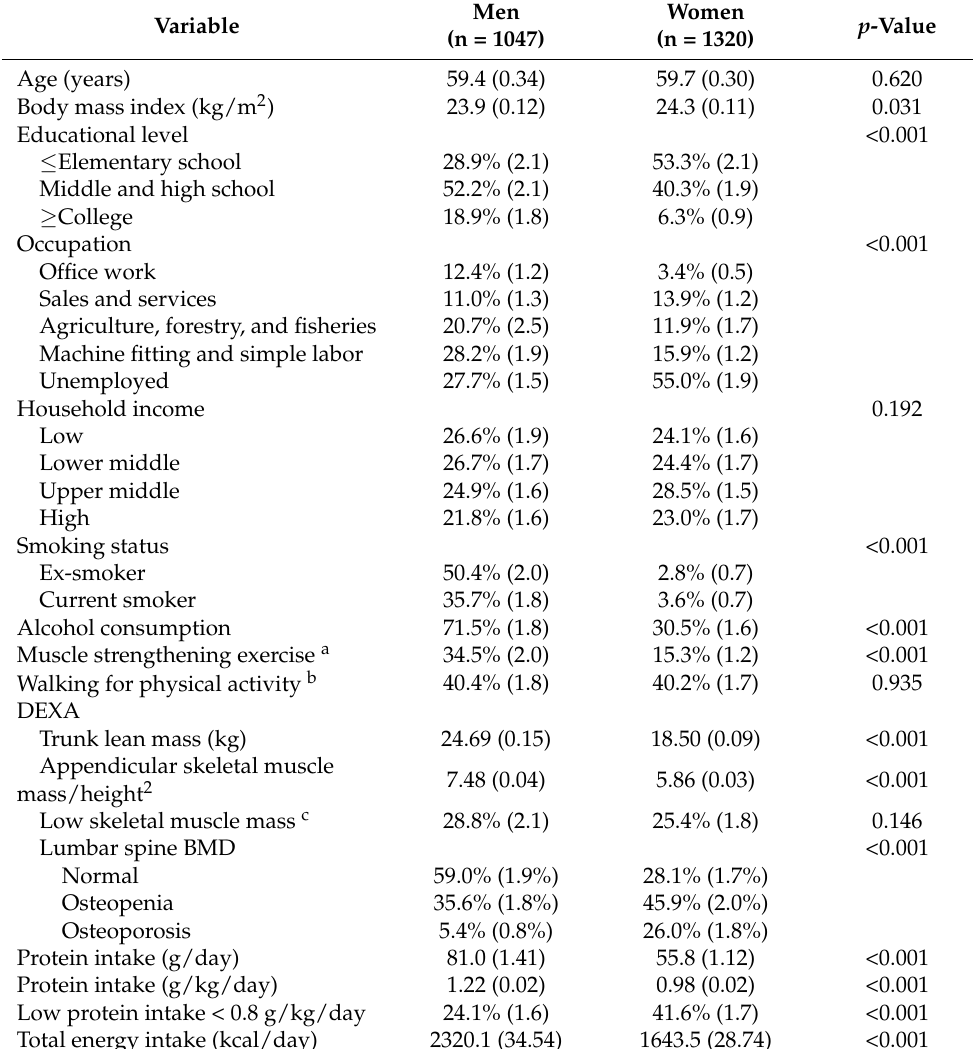
Table 1. Characteristics of study participants by